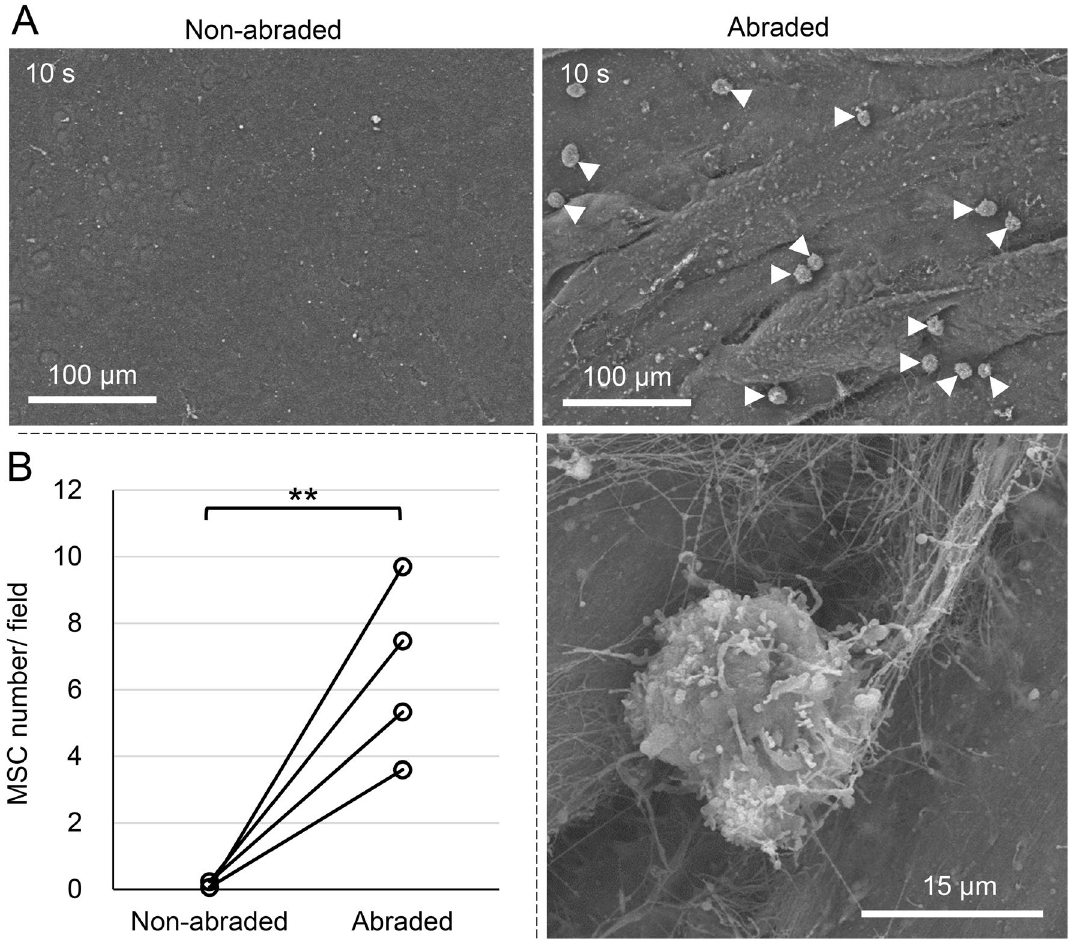
Figure 7. Influence of abrasion of the porcine cartilage surface on MSC adhesion. An MSC suspension was placed on a non-abraded or abraded pig cartilage surface for 10 s, then the cartilage was washed and observed. ( A ) SEM images. Arrowheads indicate adhered MSCs. ( B ) Quantification of adhered MSC. The number of MSCs per 320 µm × 380 µm area was counted in 9 fields per cylindrical cartilage. Three cylindrical cartilage pieces per MSC donor were used. This experiment was repeated 4 times independently and plotted (** p <